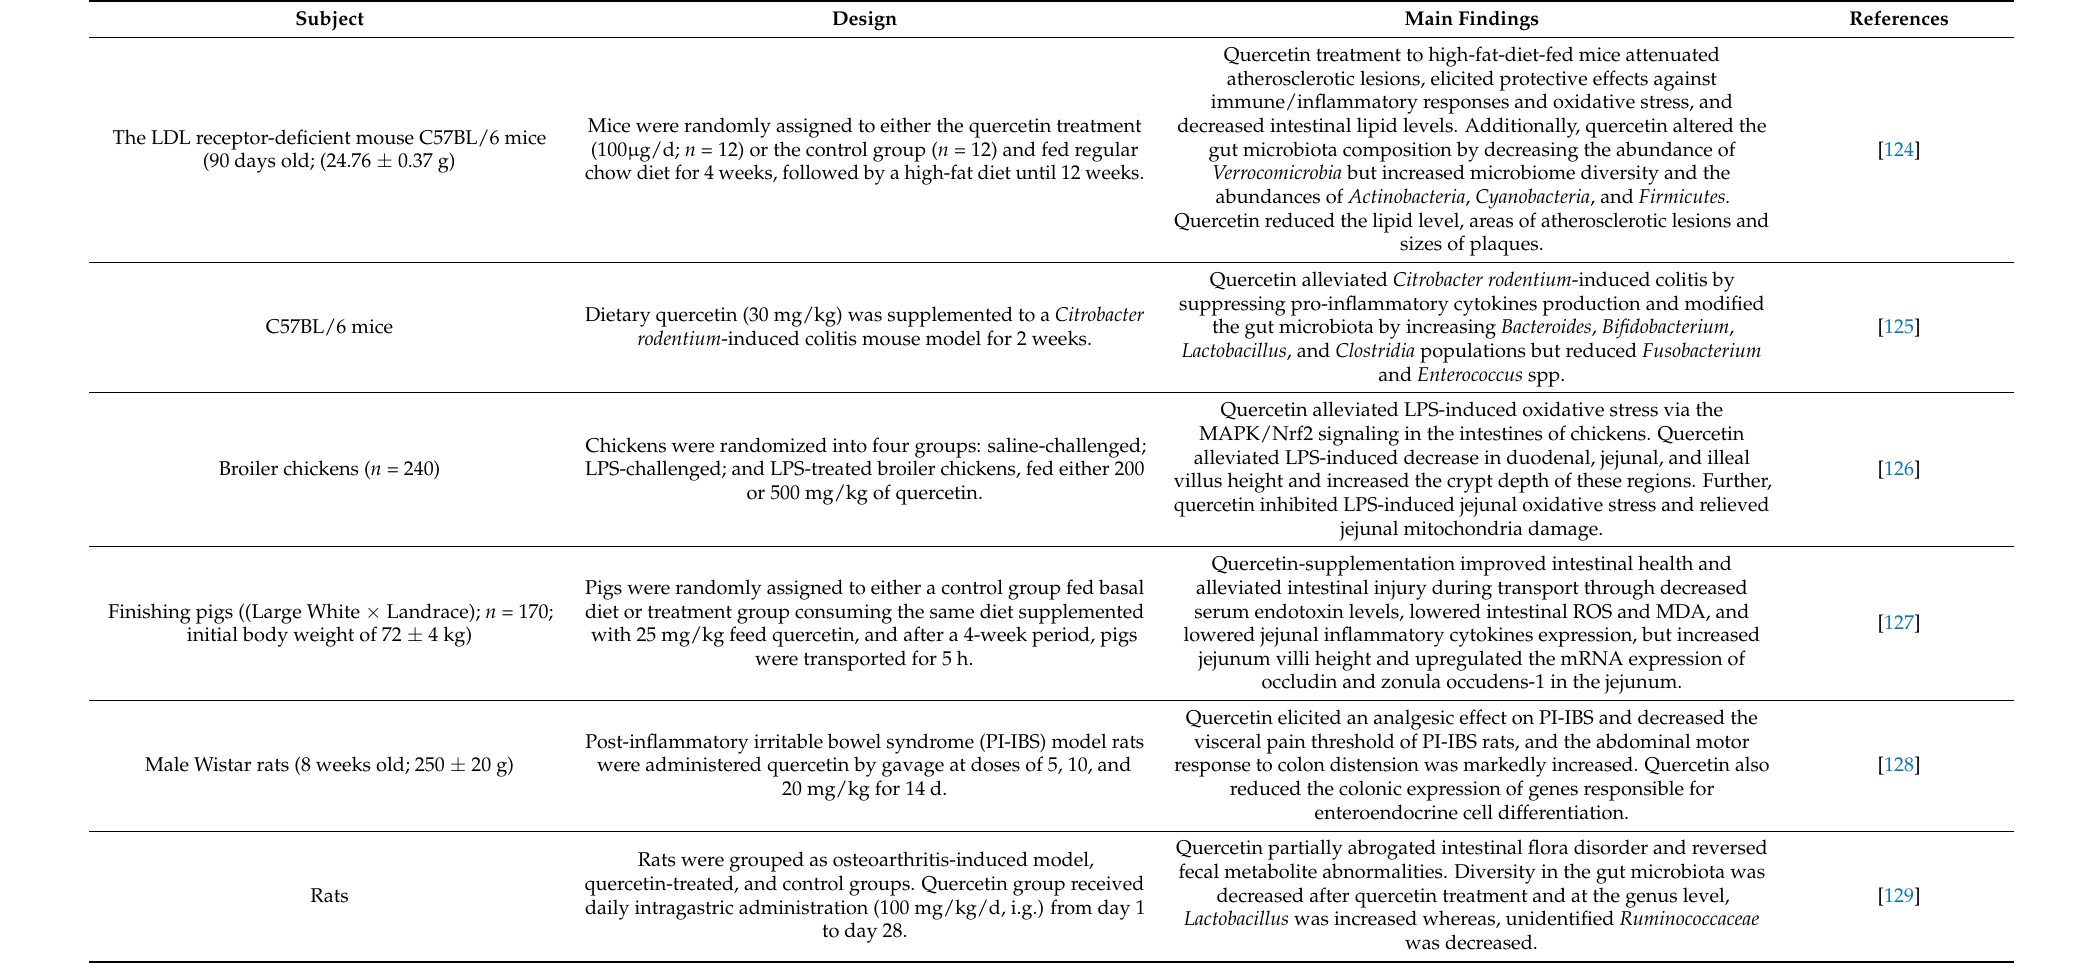
Table 2. Summarized roles of quercetin in enhancing intestinal immunity and gut health in human and animal